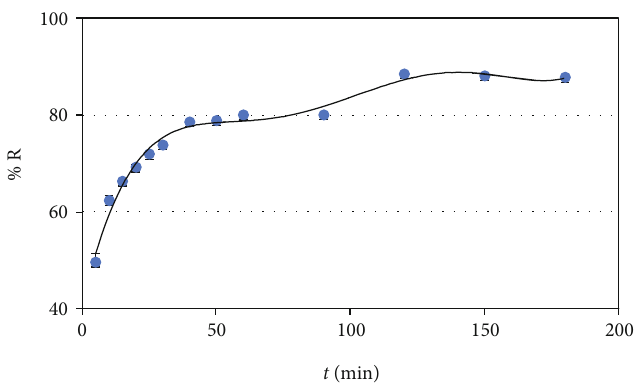
Figure 5: The e ff ect of contact time on the adsorption of MB using BC500 (room temperature, unadjusted pH, and C